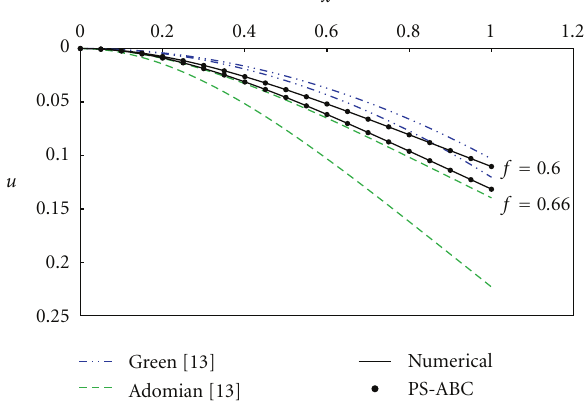
Figure 2: Buckling of MWCNT cantilever in the vicinity of graphite sheets for di ff erent values of f .